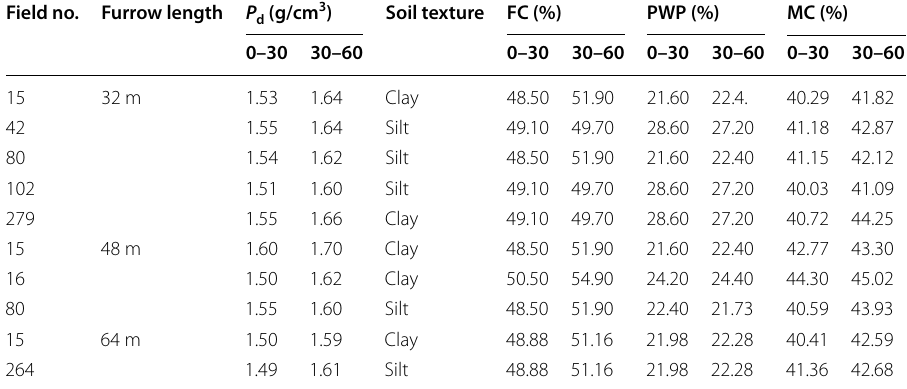
P d bulk density, FC soil moisture content at field capacity, PWP moisture content at the permanent wilting point, MC present soil moisture content, D app depth of =